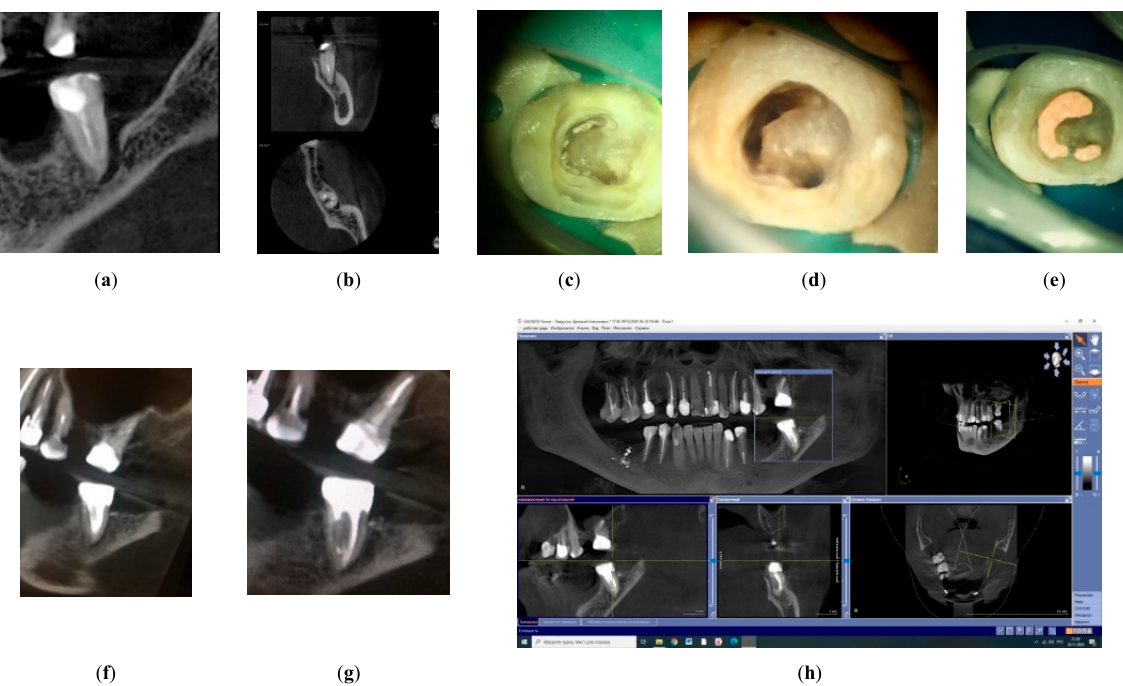
Figure 1. Clinical case 1: ( a , b ) preoperative CBCT demonstrates radiolucent lesion on the distal aspect of the second left mandibular molar; ( c ) clinical view of the access cavity, remnants of obturation material; ( d ) clinical view of the access cavity after instrumentation of the root canals; ( e ) clinical view of the access cavity after obturation of root canal treatment with GuttaFlow Bioseal; ( f , g ) postoperative CBCT demonstrates complete root canal filling; and ( h ) a follow-up CBCT (after 12 months) demonstrates healing.